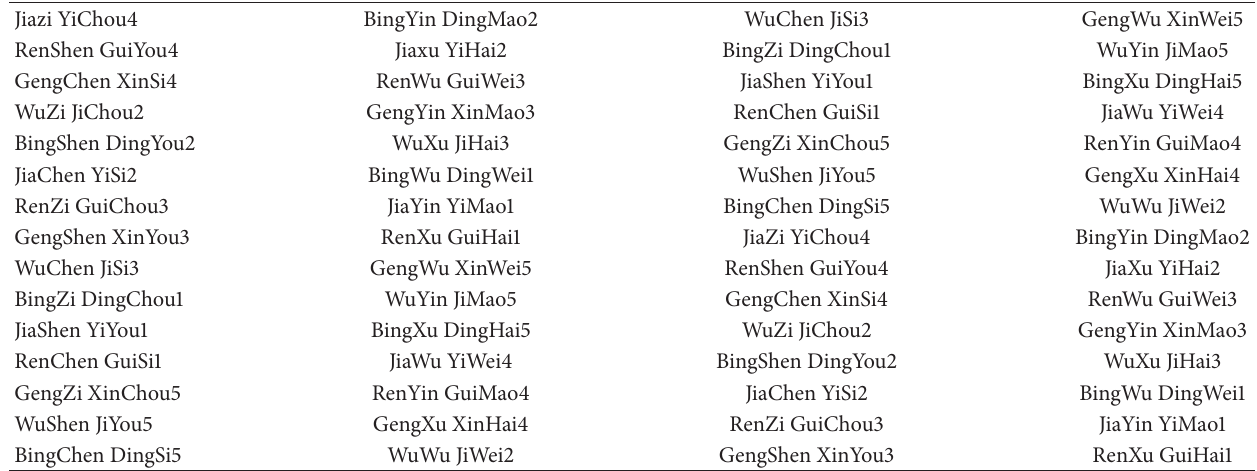
Table 4: New arrangement based on base number 8 after extending one duplicate of 60